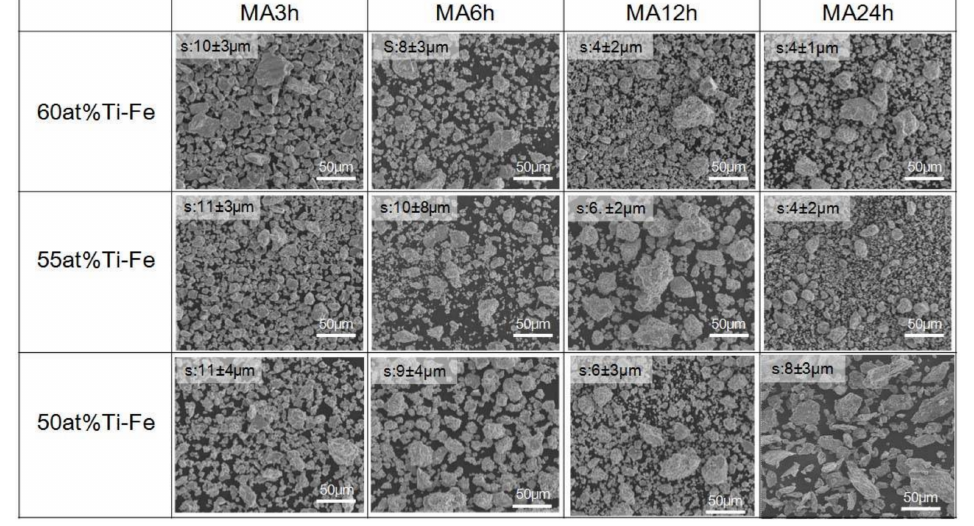
Figure 1. SEM images of mechanical alloying (MA) samples with different Ti-contents and milling time (inset values; s: mean particle size).